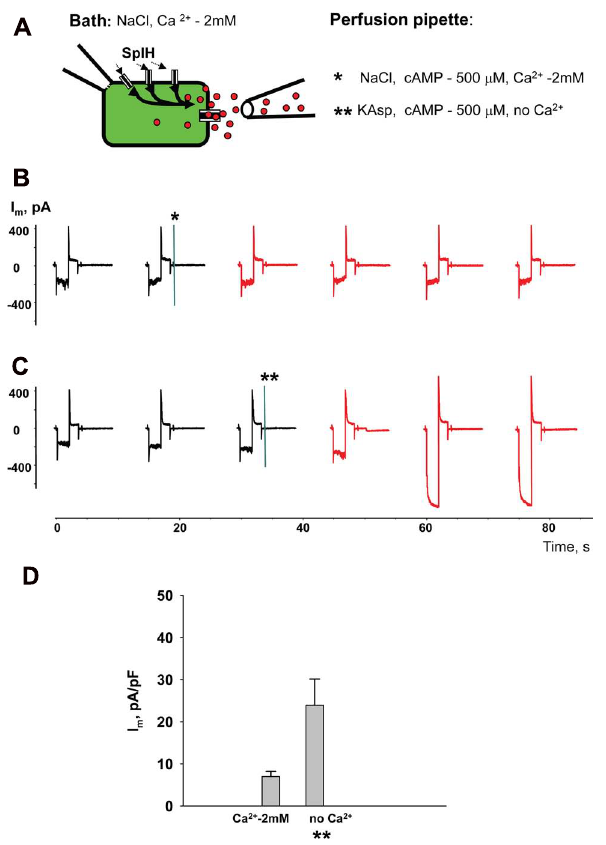
FIGURE 9 | Local hemichannel activation. (A) Schematic illustrating an experiment with local application of cAMP.The perfusion pipette containing NaCl (*) or KAsp (**) solutions was brought close to the cell and a positive pressure was applied to allow the contents of the pipette to reach the cell membrane. Local application of cAMP via the external pipette did not affect the SpIH current in HeLaCx43/SpIH cells when the perfusion pipette contained the NaCl solution ( * ):6.6 ± 1.5 and 6.9 ± 1.3 pA/pF, before and during local cAMP application, respectively; n = 6, P = 0.456 (B) . However, the SpIH currents did increase when the pipette contained the KAsp solution ( ** ) (C) . (D) Summary of current densities: 7.0 ± 1.6 and 23.9 ± 6.2 pA/pF, before and during local cAMP application, respectively; n = 6, P = 0.041. Currents marked in red in (B) and (C) correspond to recordings during the local application of cAMP; asterisks (*) and (**) indicate moments when a positive pressure was applied to the perfusion pipette.